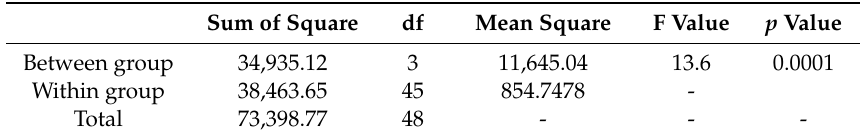
Table2. StatisticalresultsfromANOVAfordi ff erenttypesofimpellerbasedonbioethanolconcentration.